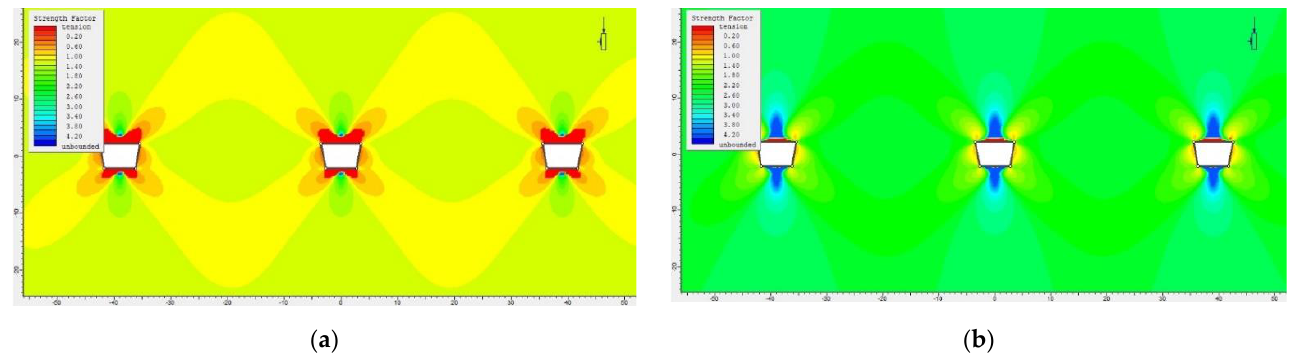
Figure 17. Distribution of strength factor values in the cross-section through entries drilled in: ( a )